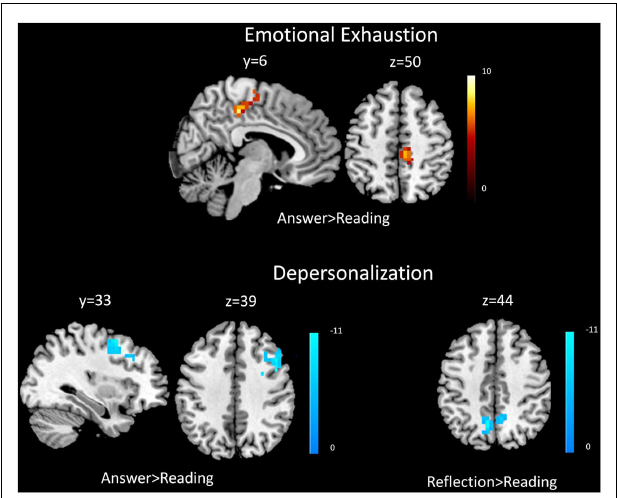
FIGURE 1 | Functional magnetic resonance imaging results . Covariate results for emotional exhaustion and the beta values of the answering > reading contrast (top panel) for residents. Covariate results for depersonalization and answering > reading contrast (left) and reflection > reading contrast (right) for residents (bottom panel).The color bar denotes the t -scores of the estimated slope of the beta values vs. the